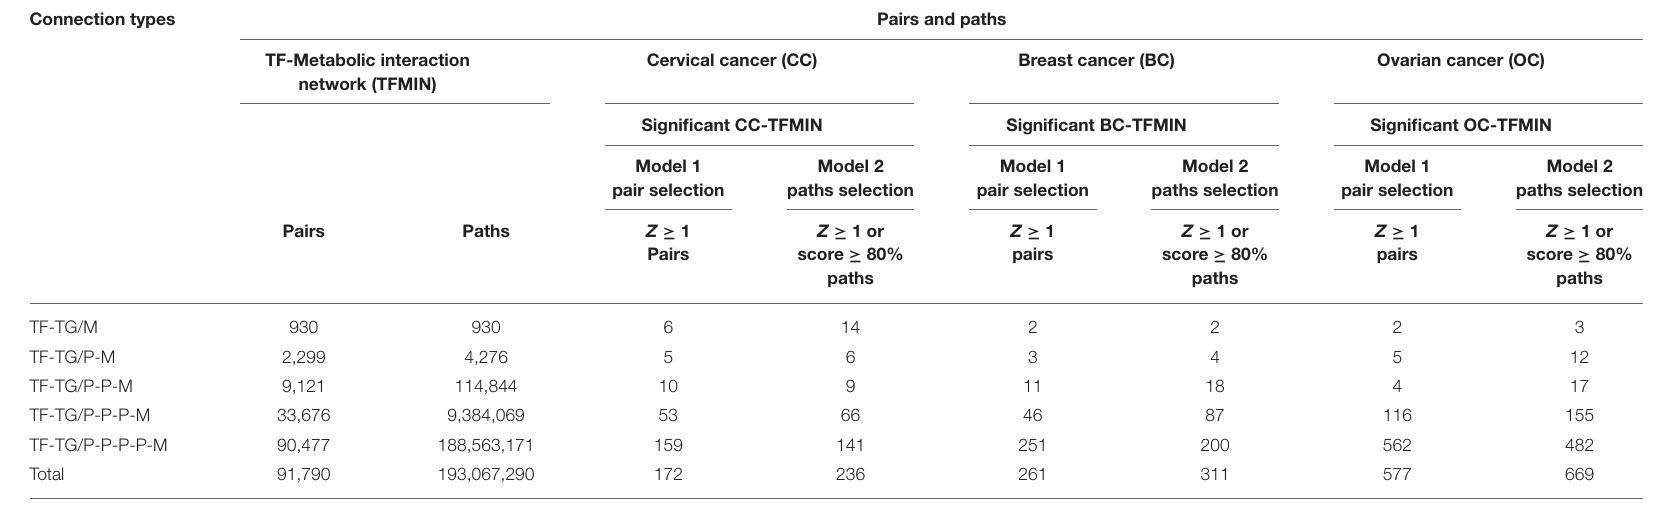
TABLE 3 | Transcription factor to metabolic pathways interconnecting paths and pairs.